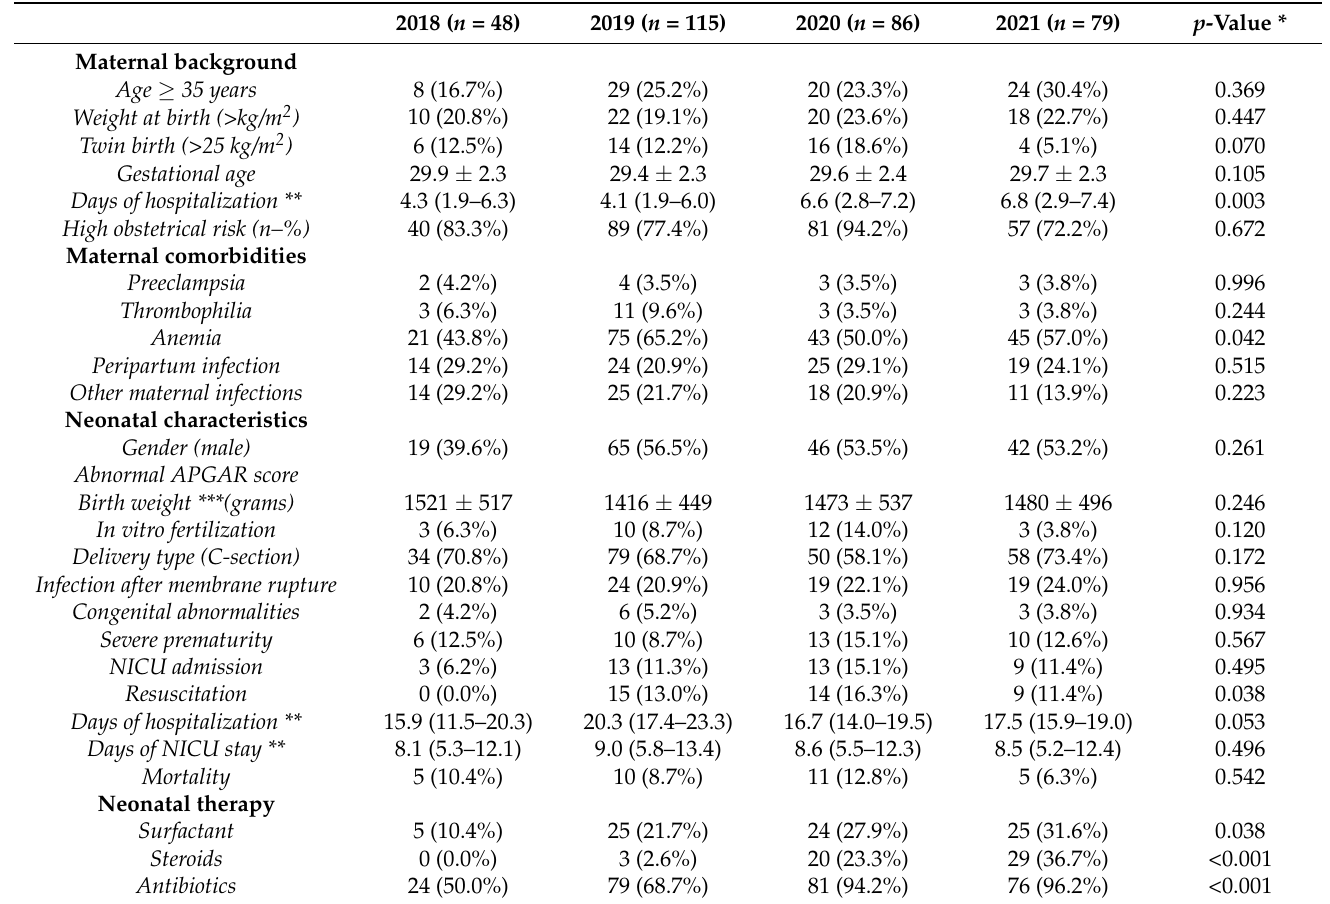
Table 2. Four-year comparison of preterm birth characteristics.